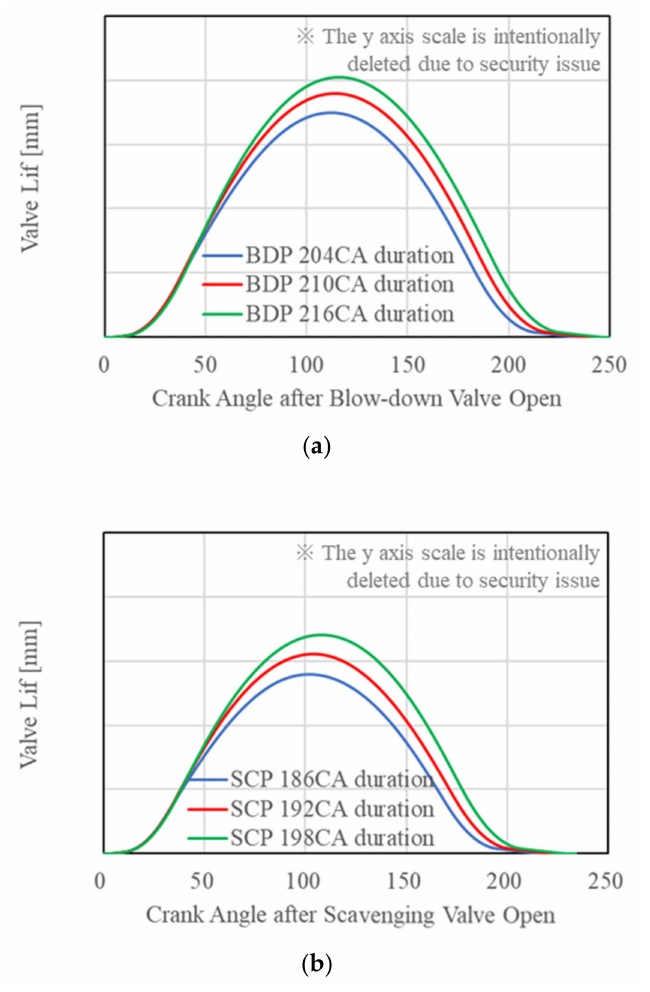
Figure 7. Initial cam profiles: ( a ) Blow-down period; ( b ) scavenging period. Optimization of the separation angle was performed again through GT power simula- tion, using the selected blowdown and scavenging valve profiles. The separation angle is defined as the crank angle period between the maximum lift timing of blowdown and scavenging valves. Figure 8 shows the results of the GT power simulation for different separation angles. The study was performed vs. cam retard angle, since the engine will utilize the base engine cam phaser. Simulations were performed for separation angles in the range of 58 –66 CA, derived based on the previous studies. From the simulation results, it could be seen that the optimal separation angle varies for the engine